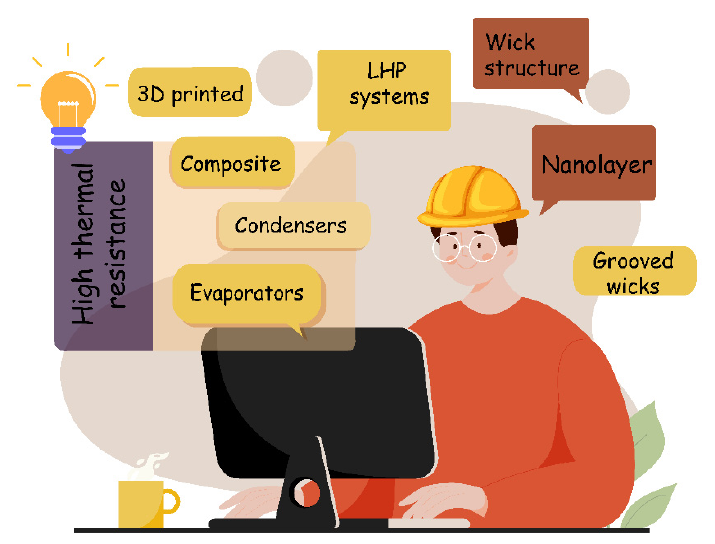
Figure 2. Designs of various LHP components to obtain high efficiency.